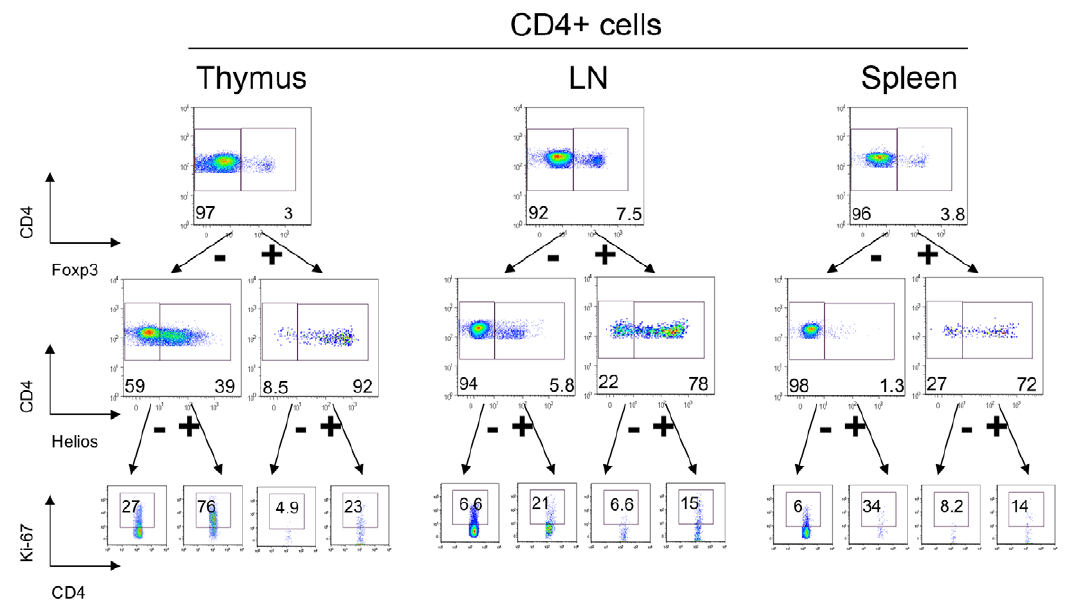
Figure 8. Helios + expression correlates with Ki-67 expression invivo . Murine thymic (left), lymph node (middle) and splenic (right) CD4 + gated cells were divided into Foxp3 + Tregs and Foxp3- cells (top row), and then divided into Helios + and Helios- subsets (middle), and Ki-67 expression within each subset was analyzed (bottom).